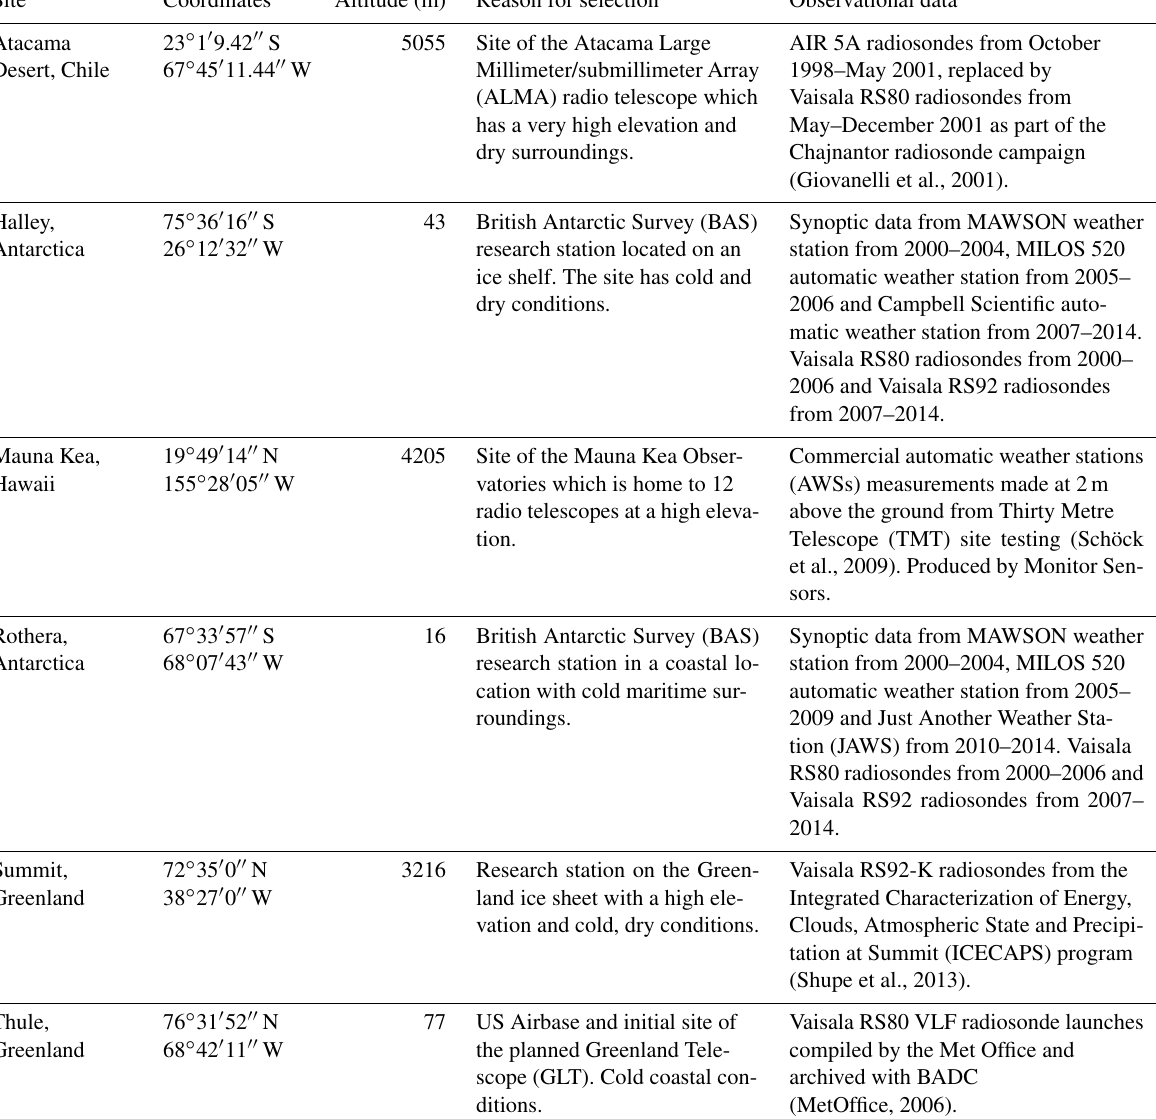
Table 1. Sites selected for submillimetre characterisation with observational